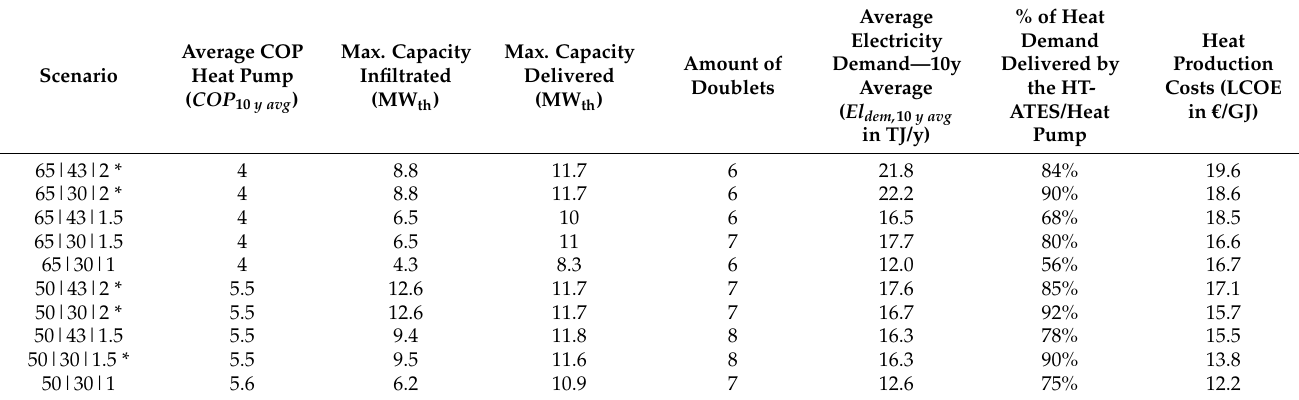
Table 6. Energetic and financial performance of the heat production and storage system as part of a multi-energy system. The % of heat delivered by the HT-ATES/heat pump is the sum of the yellow and orange bars in Figure 4. The scenario name abbreviation consists of: condenser temperature|HT-ATES threshold temperature|heat pump size